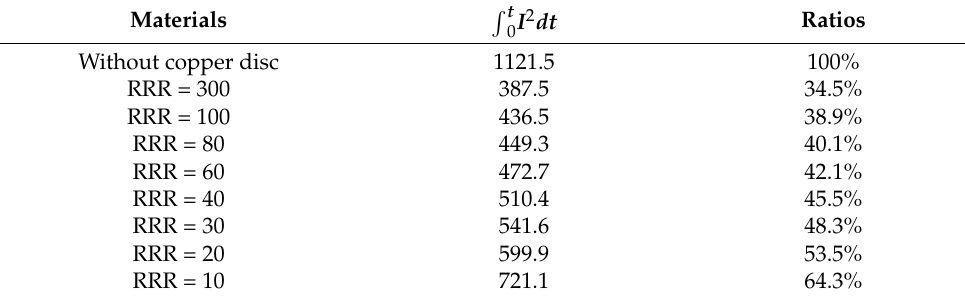
Table 4. Energy parameters of different copper